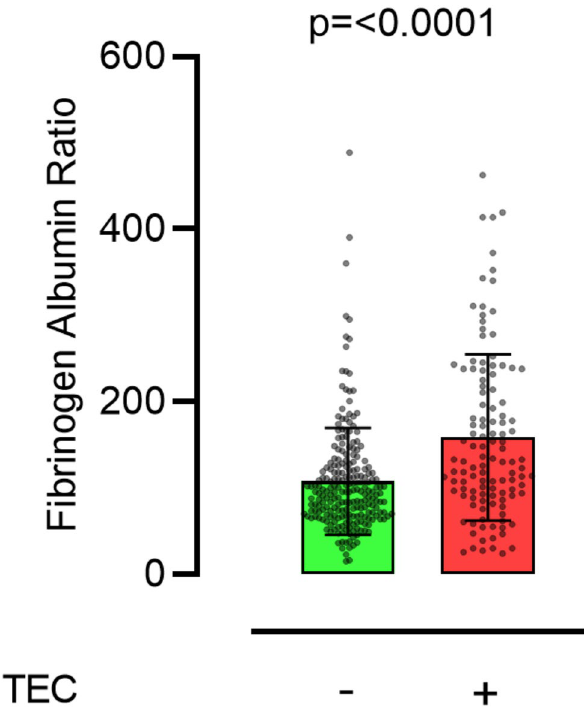
Figure 2. Box plot shows that Fibrinogen–Albumin-Ratio levels in patients with or without thromboembolic complication (TEC) are significantly